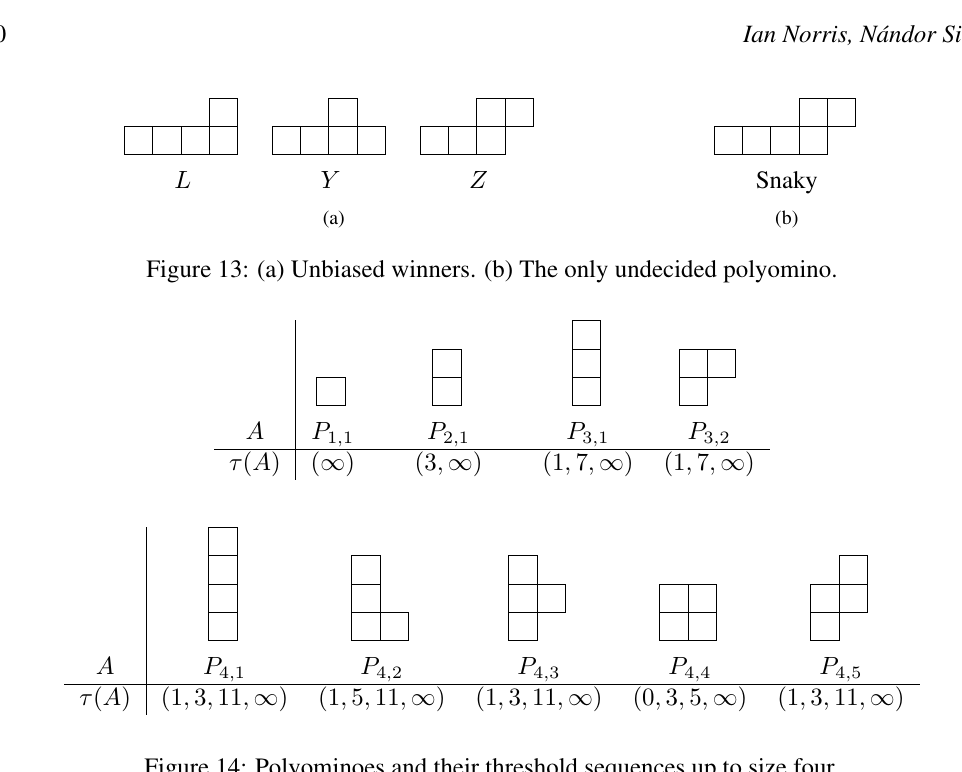
Figure 14: Polyominoes and their threshold sequences up to size